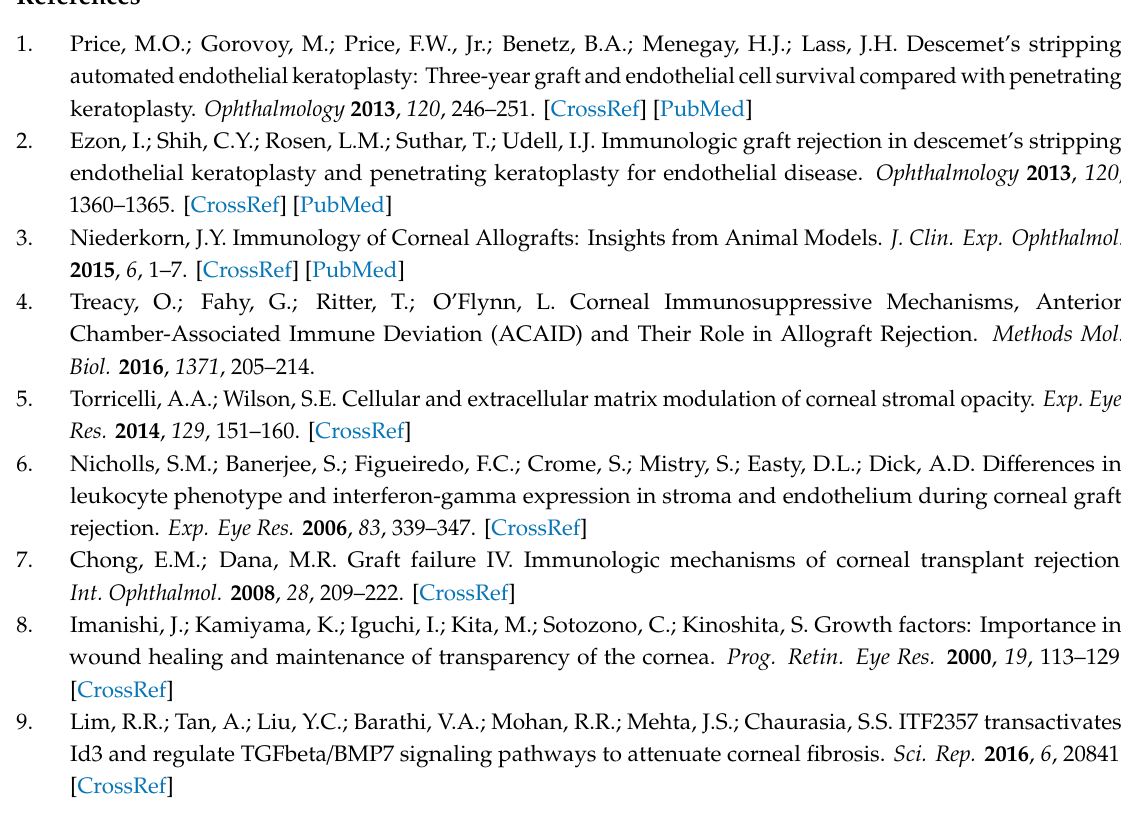
Figure S1: Substance P expression levels in the tear fluid before and after